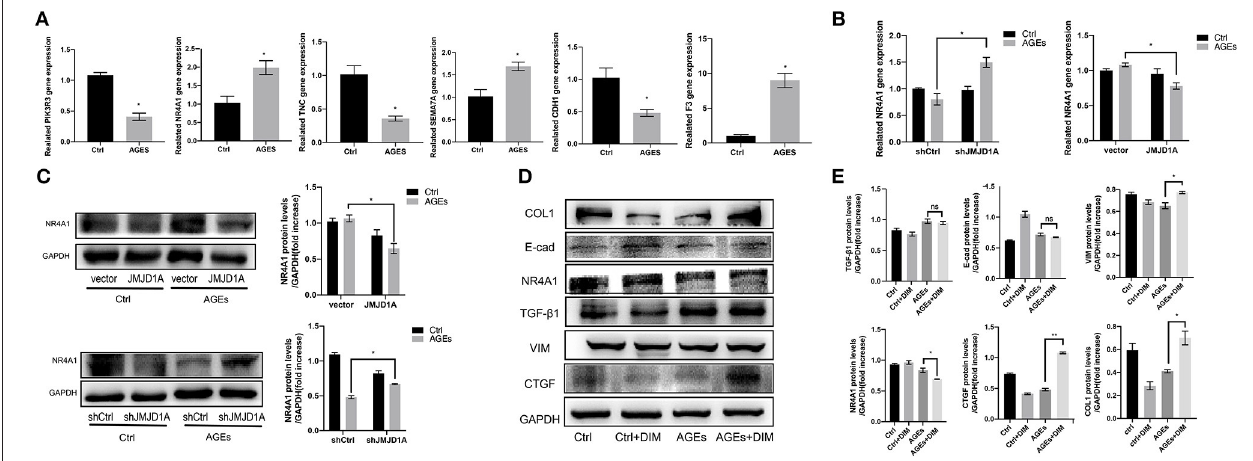
FIGURE 8 | NR4A1 may be the downstream signal factor of JMJD1A regulating HK-2 cell fibrosis. (A) The expression of transcriptome predictors (PIK3R3, NR4A1, TNC, SEMA7A, CDH1, and F3) after JMJD1A knockout in HK-2 cells by RT-qPCR( n = 3, * p < 0.05). (B,C) RT-qPCR and Western blot were used to detect the mRNA and protein expression of NR4A1 in shJMJD1A and JMJD1A group under AGEs stimulation, compared with shCtrl or vector group, NR4A1 was upregulated in shJMJD1A group, but down regulated in JMJD1A group. (D,E) NR4A1 was inhibited by the inhibitor DIM-C-pPhCO2Me (20 µ M), Western blot detected the related fibrosis, and the expression levels of VIM, TGF- β 1, CTGF, and COL1, which were higher in AGEs + DIM group compared with AGEs group ( n = 3, * p < 0.05, ** p <